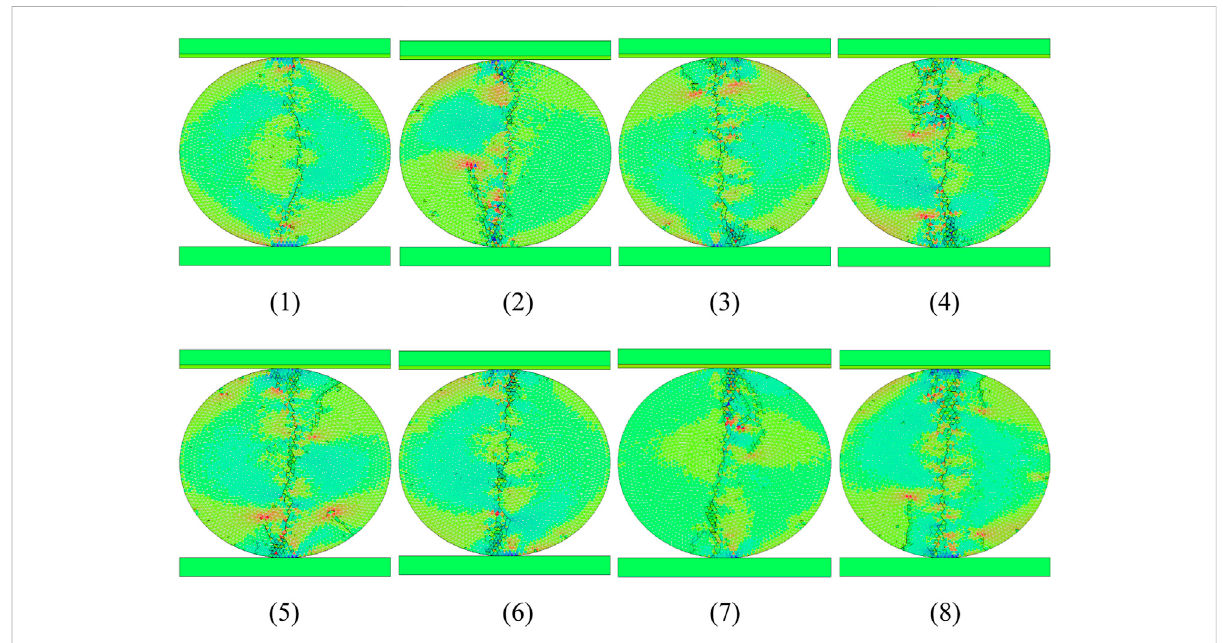
FIGURE 6 Fracturing failure patterns of the intact disc specimen with m = 5 (Ning et al., 2021).